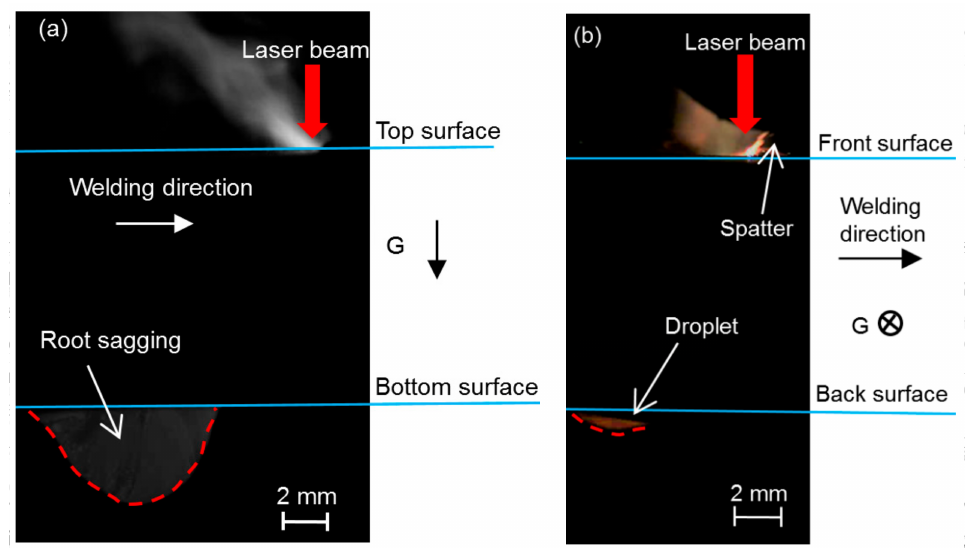
Figure 12. Images of the welding processes with different welding positions: ( a ) PA position, and ( b ) PC position (p = 10 kW, v = 0.9 m/min, ∆ = +10 mm, q = 20